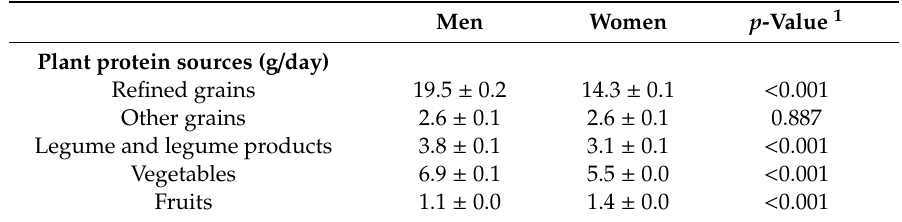
Table 2. Major food sources of plant and animal protein intake in Korean adults aged 30–64 years by